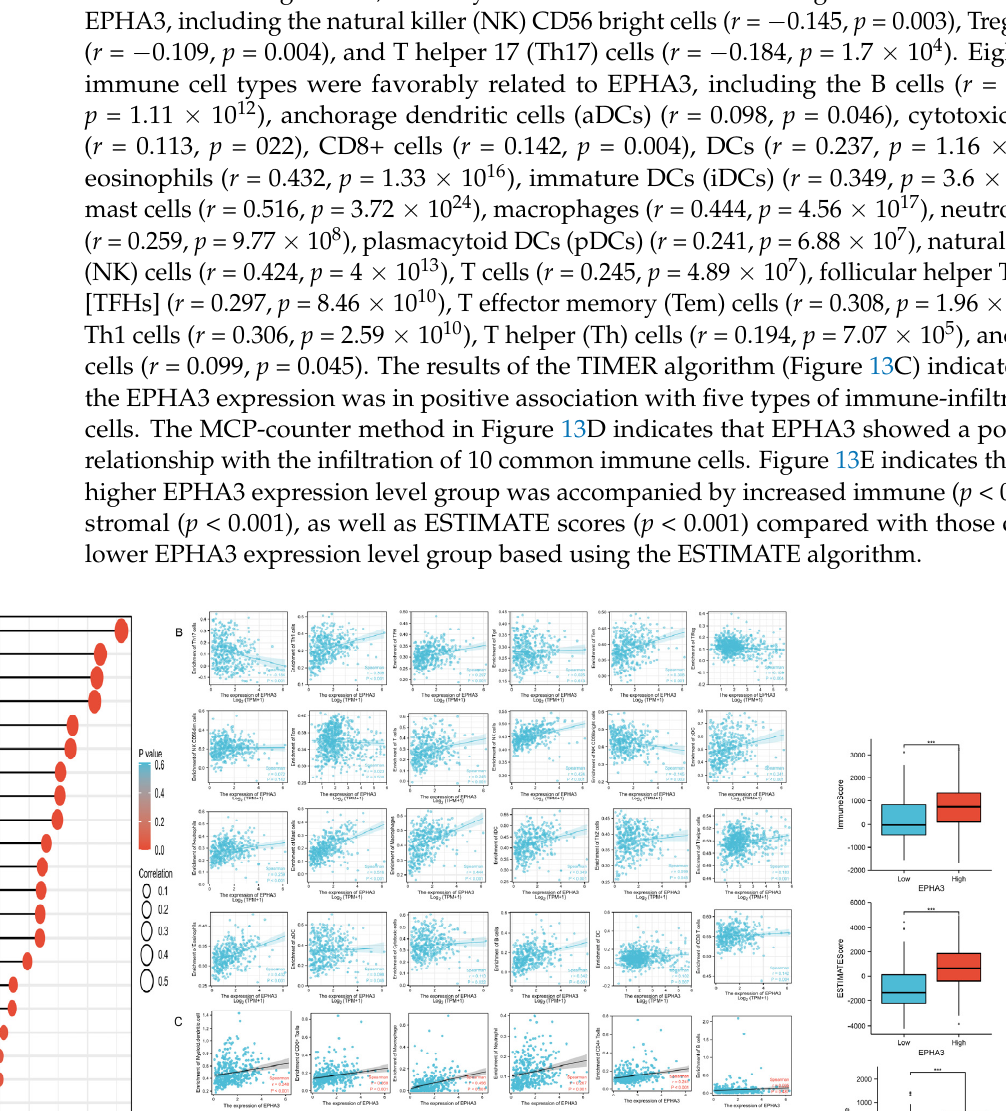
Figure 12. Different protein expressions within T24/NC, T24/EPHA3, UMUC-3/NC, and UMUC-